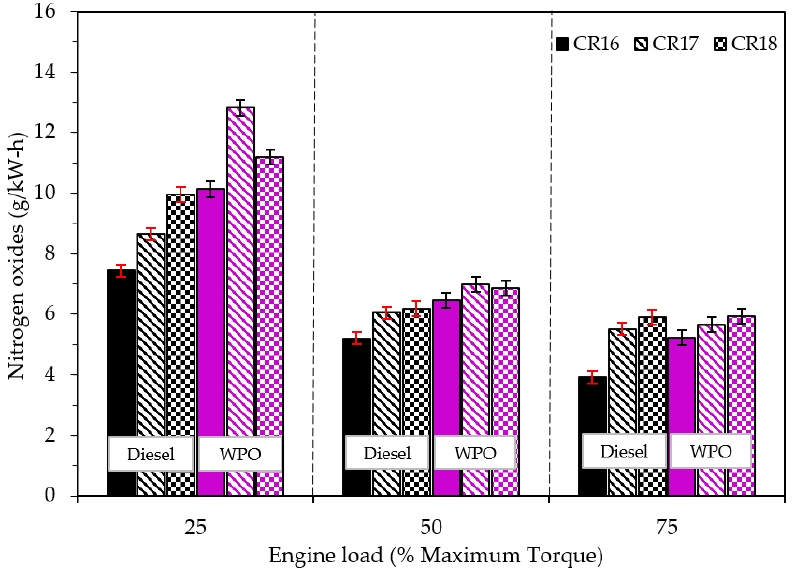
Figure 8. Variation in the nitrogen oxide (NOx) emissions with engine loads.